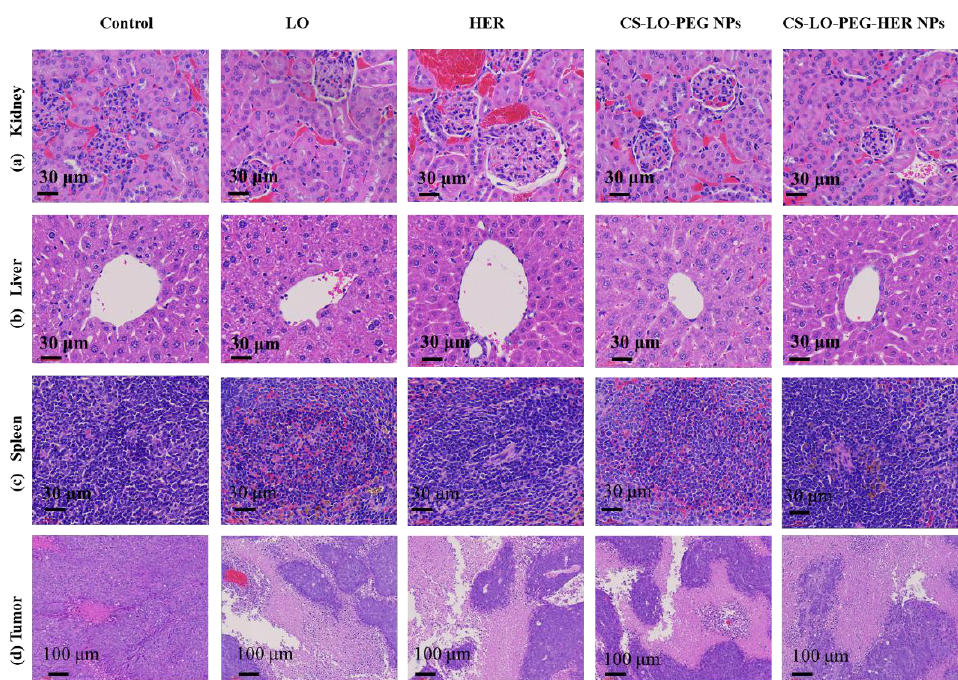
Figure 7. Effect of L-lysine α -oxidase, herceptin, and different nanoparticles treatment on histopathological changes in organs and tumor pathology. Kidney ( a ), liver ( b ), spleen ( c ), tumor ( d ). Where CS is chitosan, LO is L-lysine α -oxidase, PEG is polyethylene glycol 600, HER is herceptin (Trastuzumab).